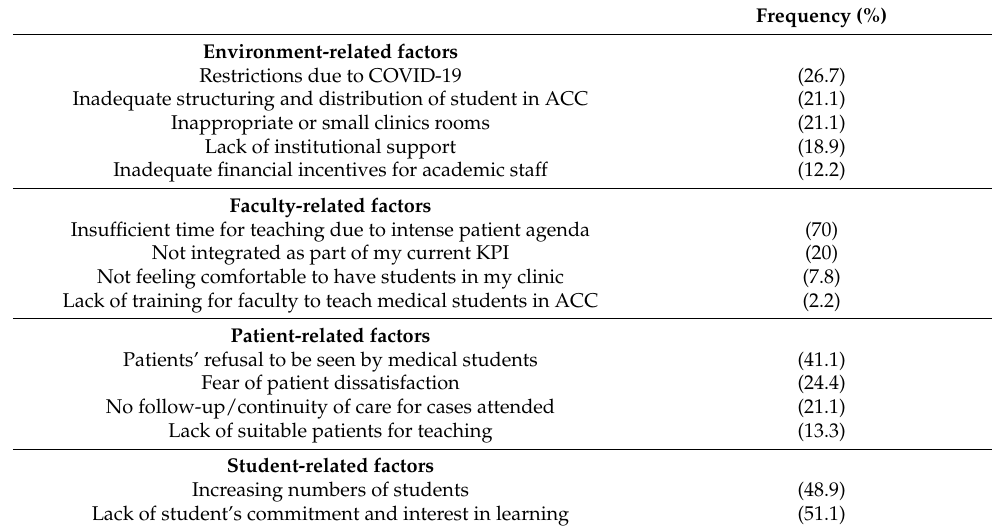
Table 7. The faculty perceived order (priority) of medical teaching barriers and challenges in outpa- tient settings.